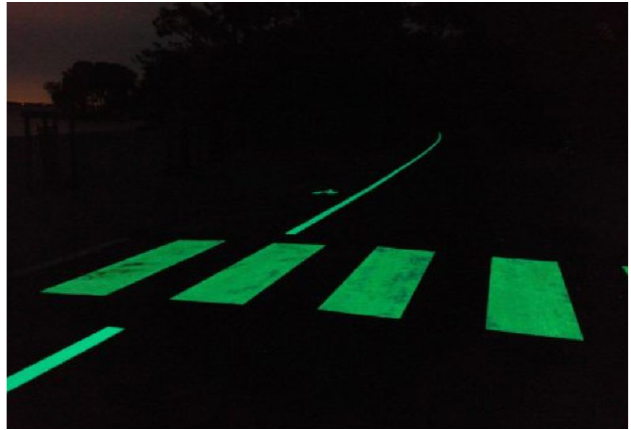
Figure 4. Luminescent road markings (Source: [24]).